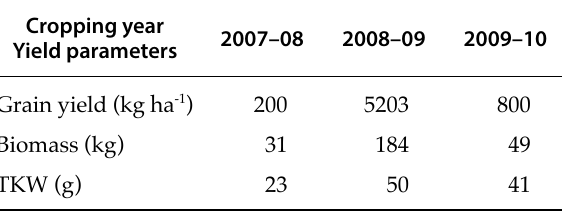
Table 3. Grain yield, biomass and thousand kernel weight (TKW) of durum wheat during 2007/08, 2008/09 and 2009/10 cropping seasons at the experimental station of INRAT at